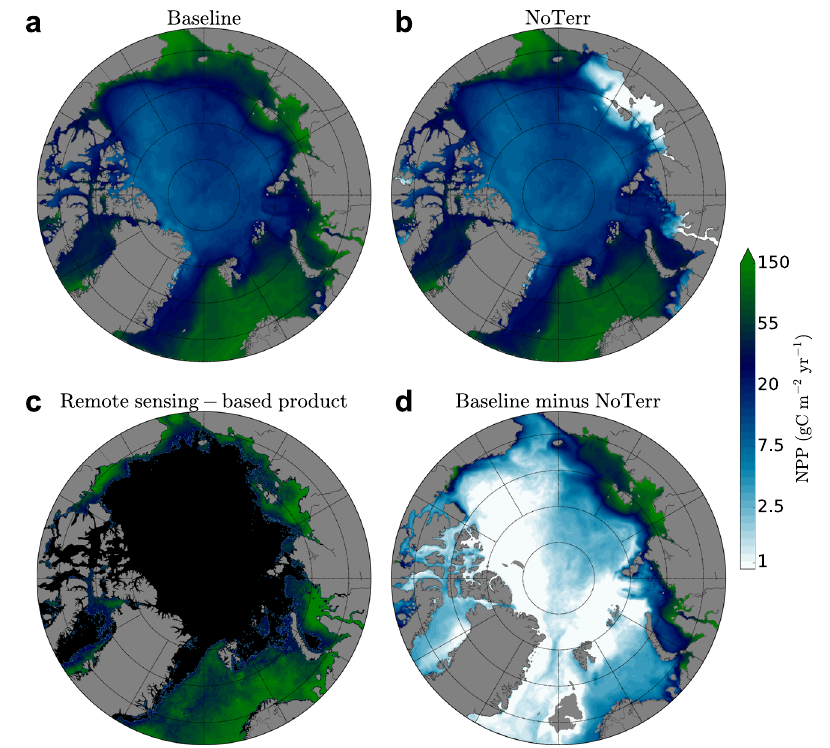
Fig. 3 Mean annual Arctic Ocean net primary production. a simulated Arctic Ocean net primary production (NPP) with observation-based nutrient input from rivers and coastal erosion (Baseline), b simulated Arctic Ocean NPP without input of terrigenous nitrogen (NoTerr) c , remote-sensing-based NPP derived from satellite observations of chlorophyll-a 11 and d difference between simulated Arctic Ocean NPP in a Baseline and b NoTerr